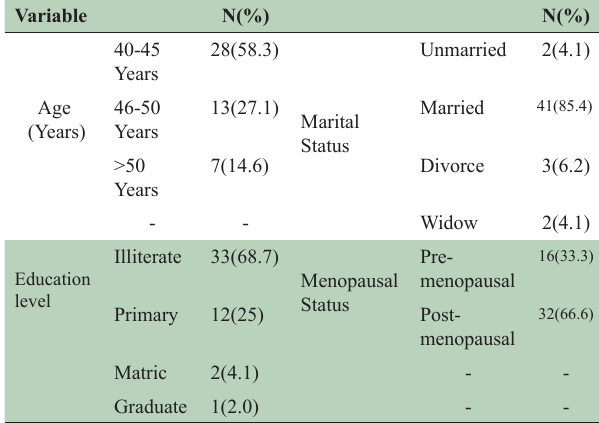
Table-I: Socio-Demographic Characteristic.